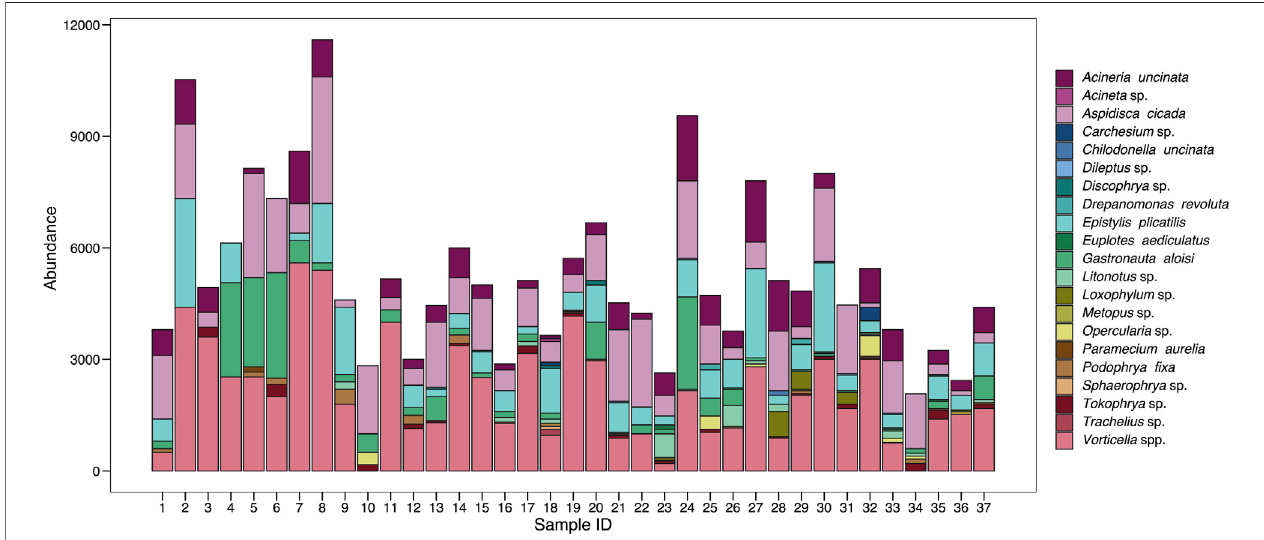
FIGURE 1 | Abundance of the different ciliate species recorded throughout 37 samplings in a wastewater treatment plant in Brazil.